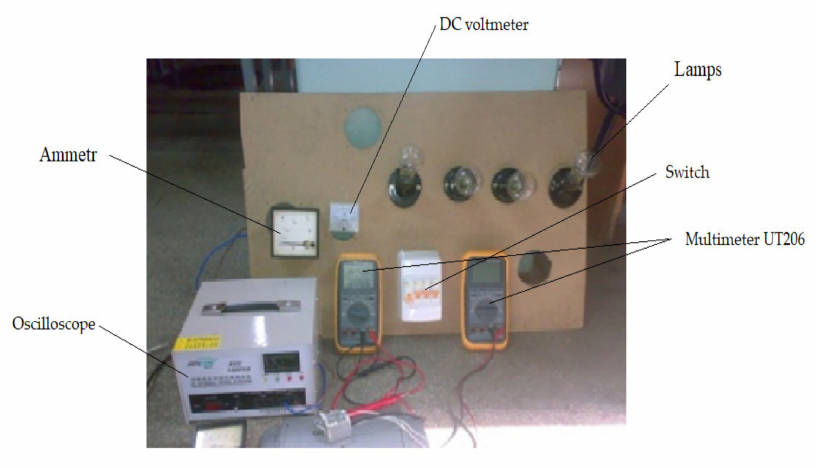
Figure 9. In experimental studies on the photovoltaic panel.